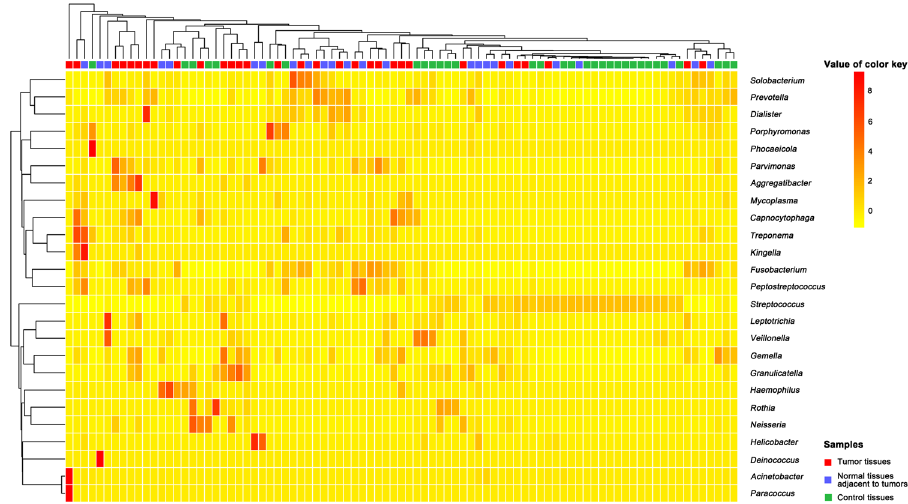
Figure 2. Hierarchical dendrogram showing taxonomic assignments from laryngeal samples. The heatmap summarizes the relative abundances of the 25 most abundant genera based on the analysis of laryngeal tissue samples. The legend in the upper-right corner of the figure shows the colors that correspond to the relative abundances of genera in each sample (expressed as a percentage of the total 16S rRNA sequences). The legend in the lower-right corner of the figure indicates the three groups of tissue samples. The tumor tissues and the normal tissues adjacent to tumor sites (NATs) were collected from laryngeal carcinoma patients, and the control tissues were collected from subjects with vocal cord polyps. The clusters of the three groups of samples based on bacterial communities are significant ( p < 0.05), and the related p values were generated using a CrossMatch